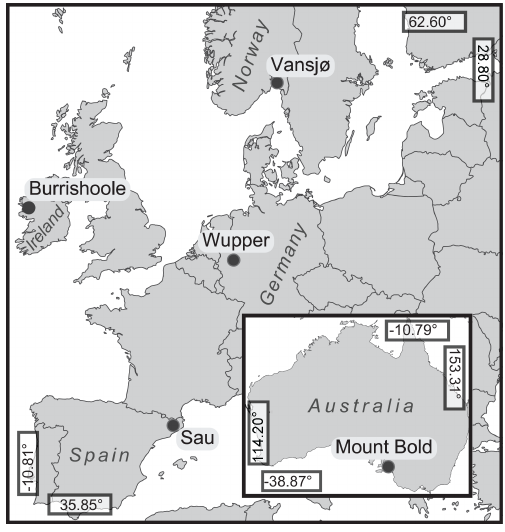
Figure 1. Location of the five study sites in Europe and